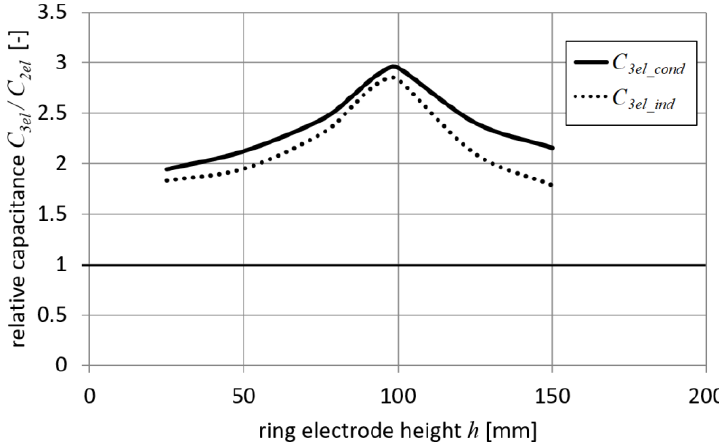
Figure 7. Droplet capacitance C 3 el values for induction and conductive charging methods, relative to the capacitance of the 2-electrode system C 2 el , as a function of ring electrode height h . Simulation parameters: r d = 40 mm, t d = 20 mm (i.e., narrow ring electrode and a small target).